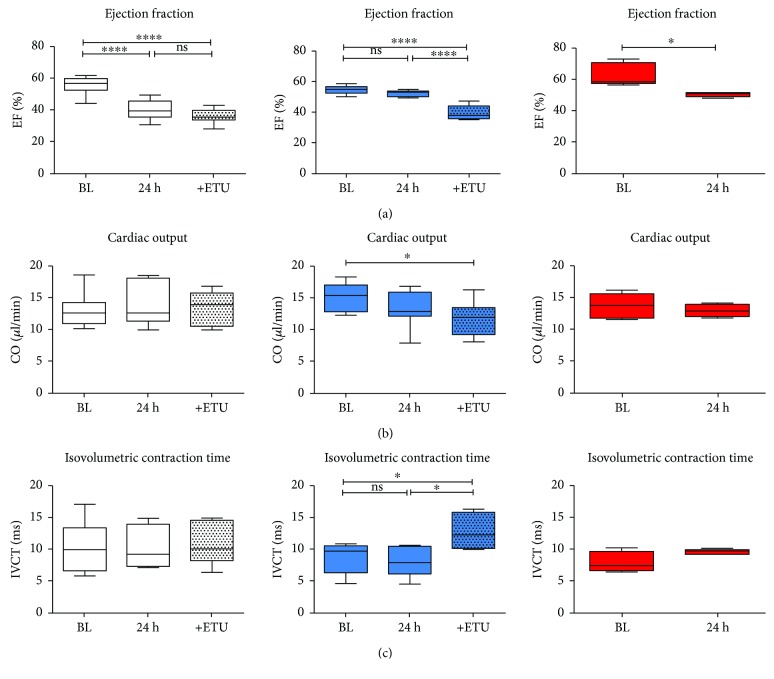
Left ventricular systolic function following AMI in Nrf2 KO mice is preserved by NOS. (a) In WT (white box plots) and eNOS KO (red box plots) mice, ejection fraction (EF) was significantly decreased 24 h after AMI, whereas it was essentially unchanged in Nrf2 KO mice (blue box plots). ETU application resulted in an impairment of systolic function in Nrf2 KO mice, but not in WT mice, indicating NOS-dependent preservation of cardiac function in Nrf2 KO mice as compared to WT mice. (b) Cardiac output (CO) was significantly decreased after ETU application in Nrf2 KO mice indicating eNOS-dependent preservation of systolic function after I/R. (c) IVCT was increased after ETU application in Nrf2 KO mice, but not in WT mice. WT mice: n = 9, Nrf2 KO mice: n = 8; Browne-Forsythe test p > 0.05, means ± quartiles, one-way ANOVA, except for eNOS KO mice (red boxes): 4-5, unpaired t-test. ∗
p < 0.05 and ∗∗∗∗
p < 0.0001.